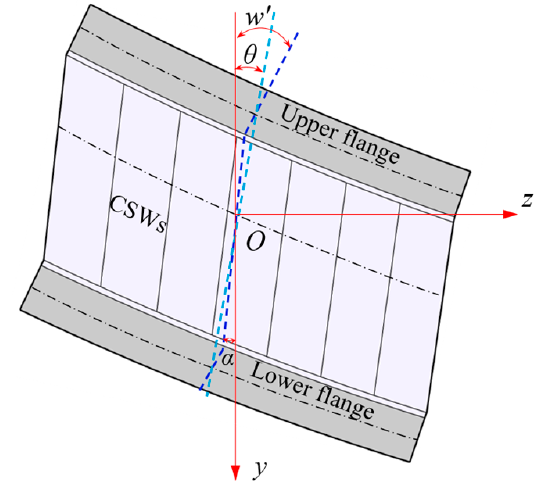
Figure 2. Vertical flexural deformation of CBG-CSWs.